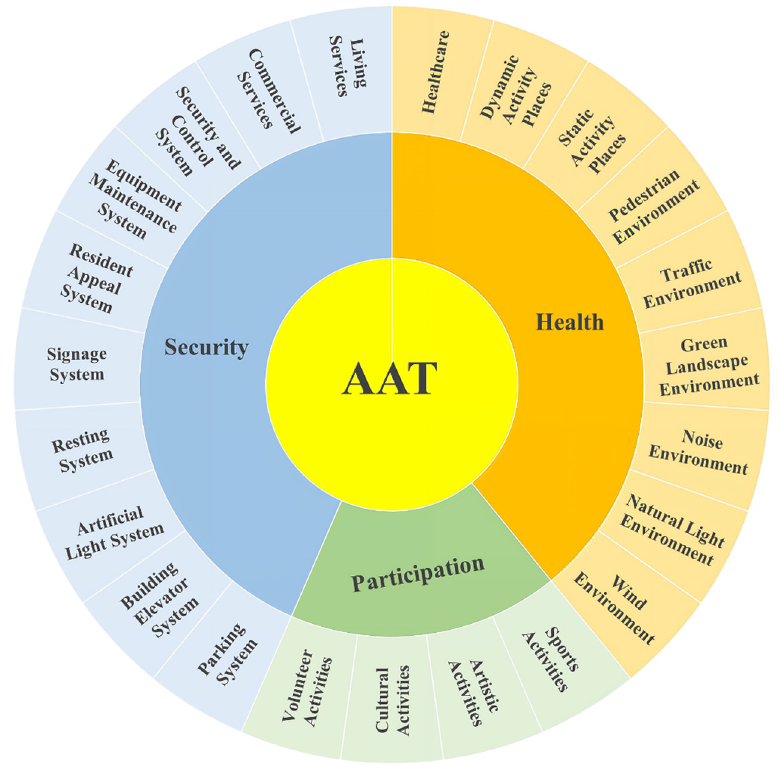
Figure 5. Modi fi ed classi fi cation of indicators. Figure 5. Modified classification of